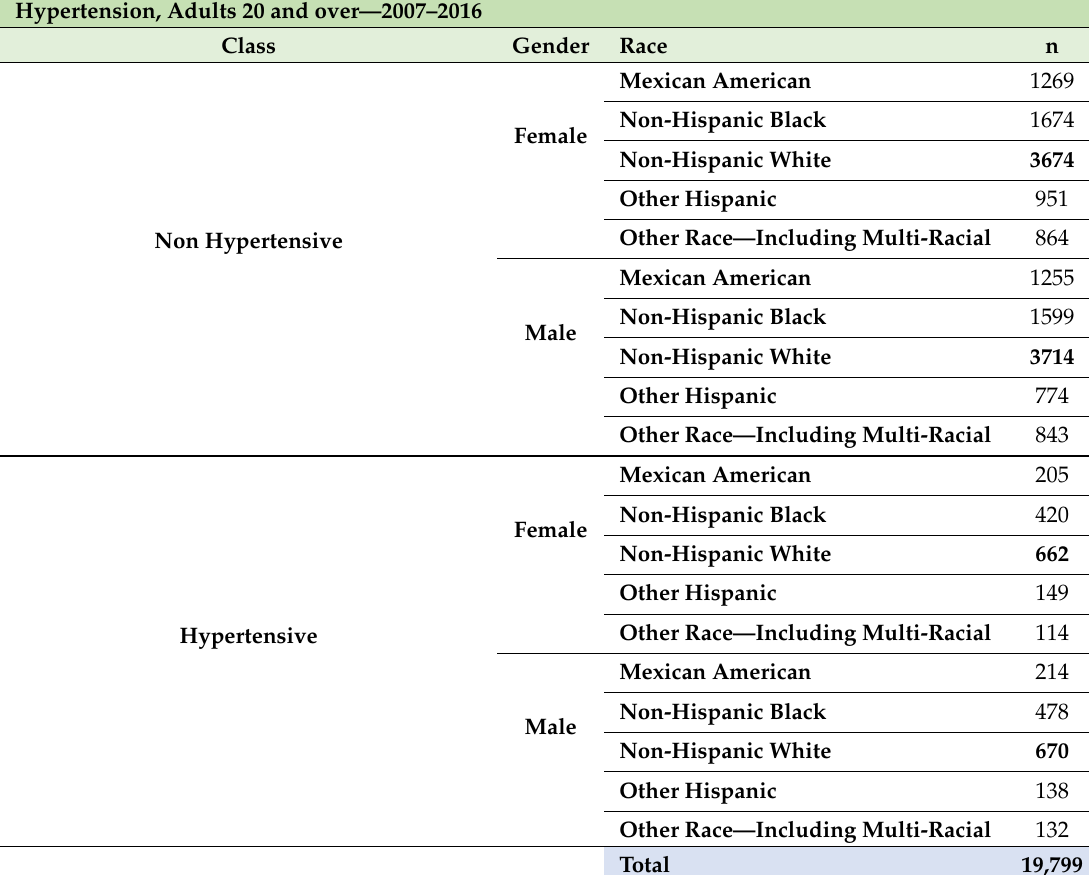
Table 1. Number of samples by hypertensive class, gender, and